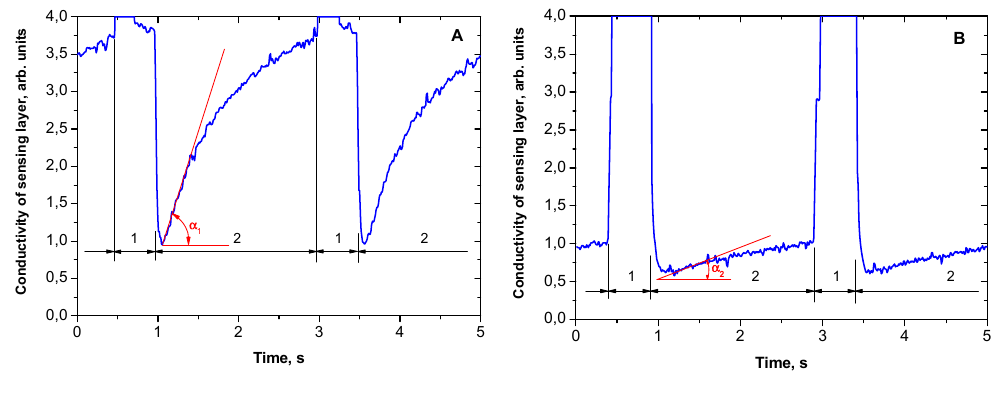
Figure 5. ( A ) Response of MEMS based sensor to 3 ppm of CO. Sensing material is SnO 2 (10 nm particles) + 3 wt.% of Pd. Measurement cycle is 450 °C (0.5 s) + 110 °C (2.5 s). The slope of the curve (tan α 1 ) is proportional to CO concentration. ( B ) Response of MEMS based sensor to 3 ppm of H 2 . Sensing material and measurement cycle are the same as those in (A). The slope of the curve (tan α 2 ) is proportional to H 2 concentration. Selectivity factor for the CO/H 2 is equal to about 10, that is the ratio of slopes at the same concentrations of CO and H 2 (tan α 1 /tan α 2 ) ≈ 10.